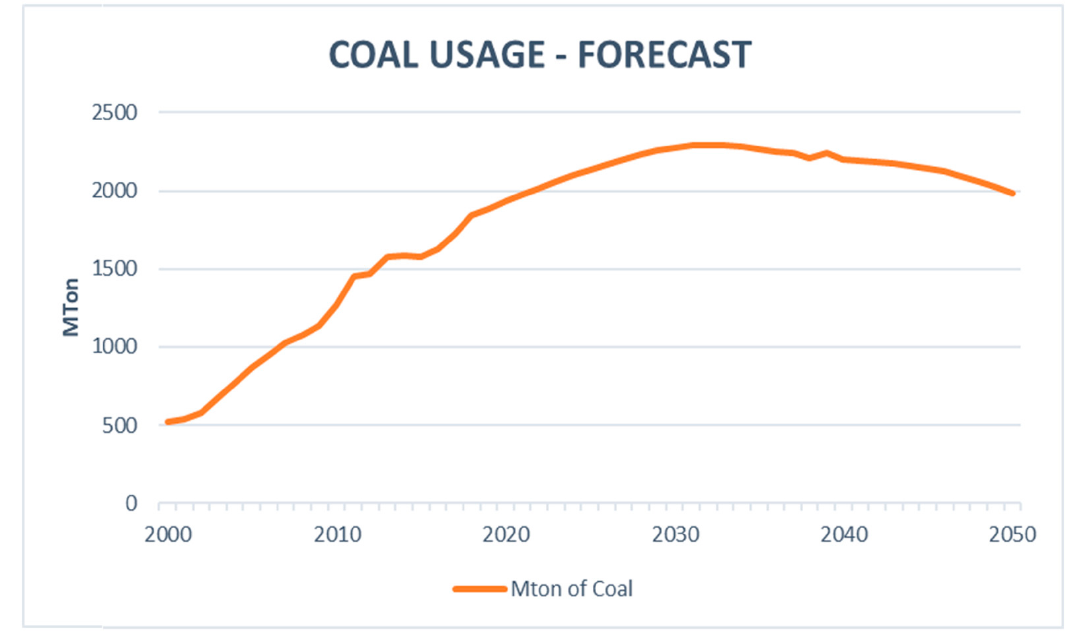
Figure 7. Coal usage according to EIA forecast.